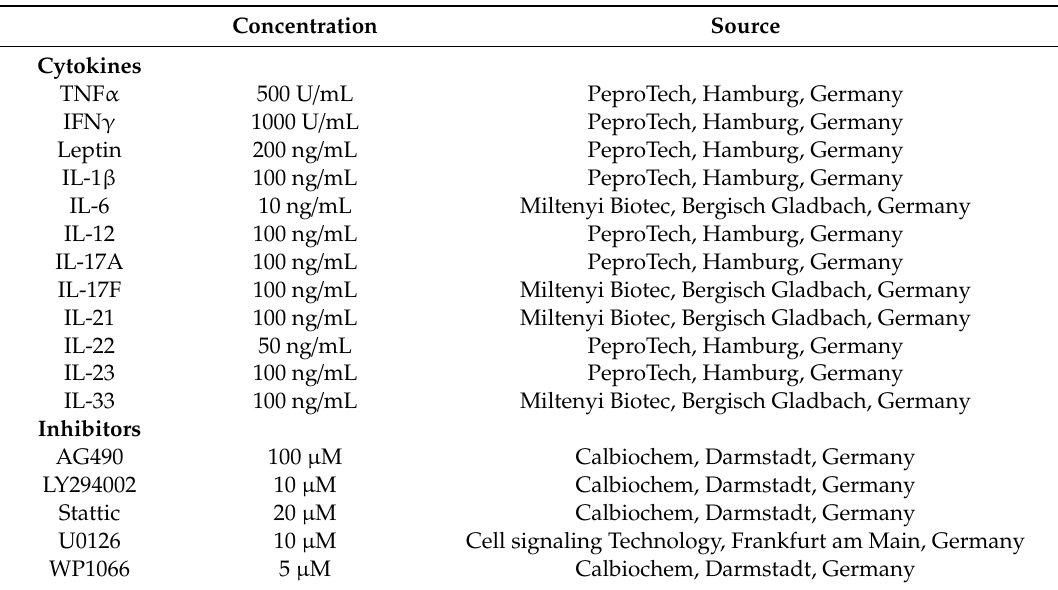
Table 3. Cytokines and